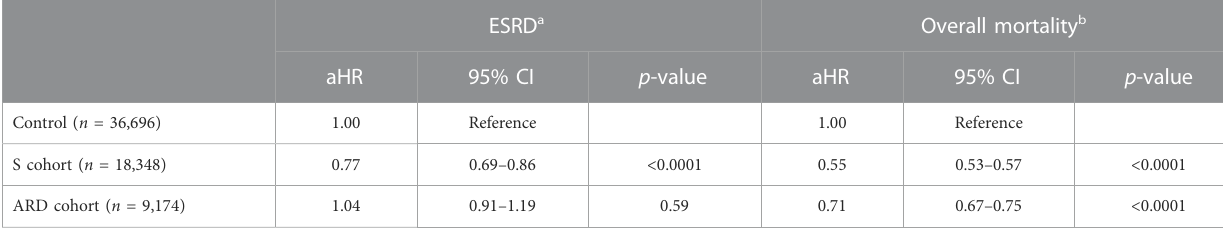
TABLE 3 Adjusted hazard ratios for end-stage renal disease and the overall mortality in the three cohorts.